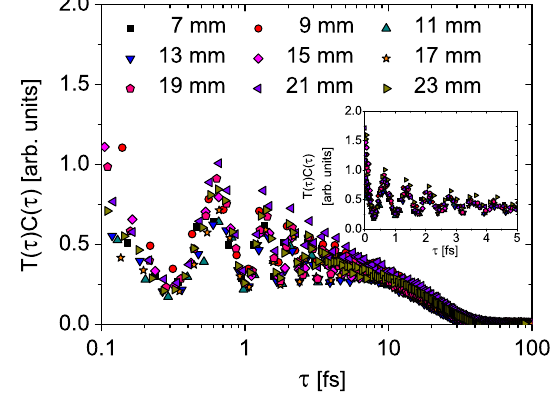
FIG. 12. Power spectra fit the master curve under the scaling of Eq. (13). Inset shows the enlarged region corresponding to τ < 5 fs to evidence the fine superposition of Talbot oscillations.